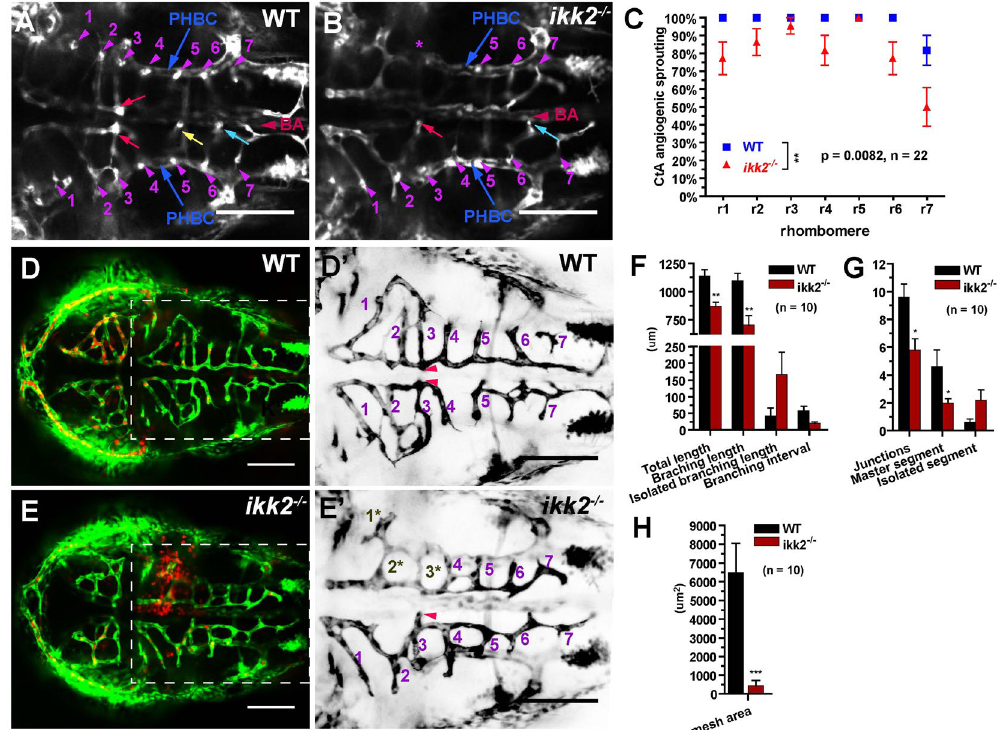
Figure 3. Loss of Ikk2 affects angiogenesis. ( A , B ) Confocal horizontal section of ventral hindbrain in wild- type and ikk2 − / − (zygotic) embryos obtained from heterozygotic parents of Tg(fli:EGFP) background at 48 hpf. CtA (purple arrowhead) stem sprouting from PHBC in each rhombomere (r) was marked accordingly. At this stage, the bilateral CtAs in the r3 formed two connections with lumen to BA (yellow arrow) in wild-type and only one in ikk2 − / − embryo. Connections of CtAs in r5 (yellow) and r6 (blue) marked. ( C ) Quantification of CtA sprouting from PHBC in each rhombomere. P value calculated by paired Student’s t test. ( D , E ) Confocal projection of CtA angiogenic vessels in Tg(fli:EGFP)/Tg(gata:DsRed) 48 hpf embryos. ( J ′ , K ′ ) Blowup shows the hindbrain of Tg(fli:EGFP)- labelled CtA vessels. Numbers correspond to the rhombomeres containing CtA sprouts. Note that 1 * , 2 * , 3 * marked the CtA vessels that were reduced both in size and connectivity in ikk2 − / − embryos. This is the area of hemorrhage ( E ). ( F – H ) Quantification of angiogenic index of hindbrain CtAs. P value calculated by Student’s t test. All data are expressed as mean ± SEM; scale bar in all panels: 100 μ